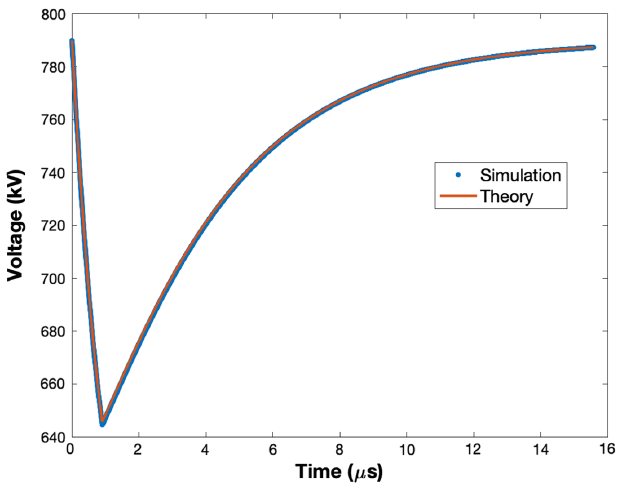
FIG. 26. Cavity voltage transient due to beam